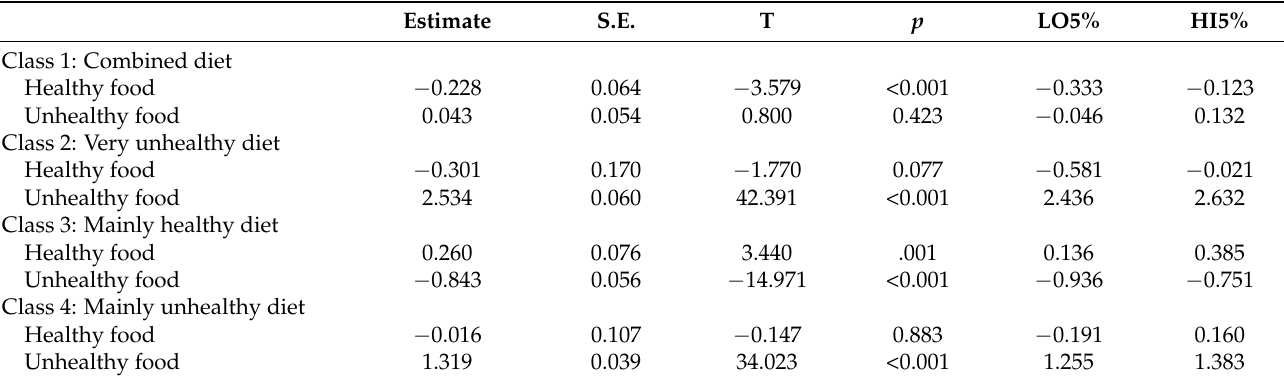
Table 3. Descriptive statistics of the four diet